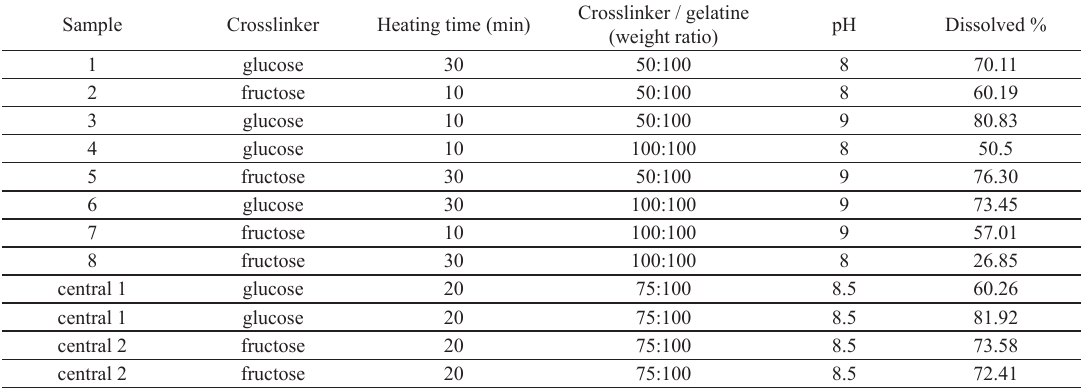
Table 1. Composition and dissolved percentage of samples.